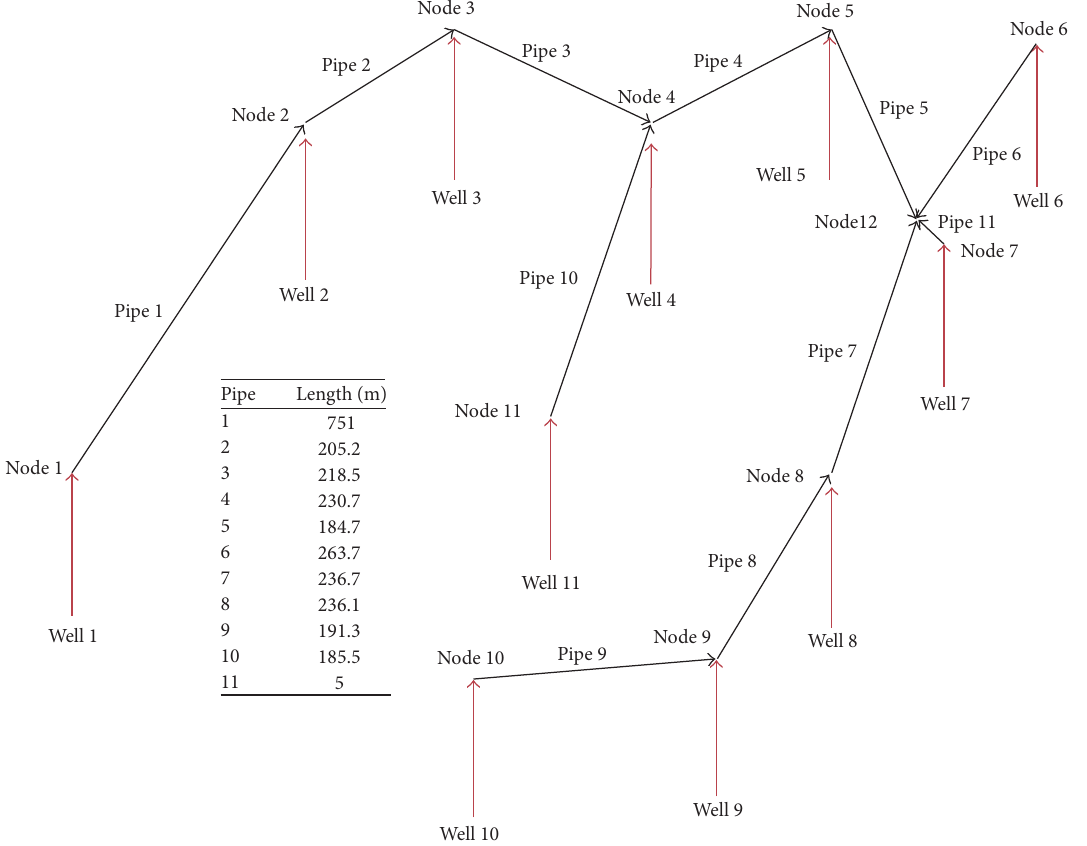
Figure 10: Surface pipeline network system.